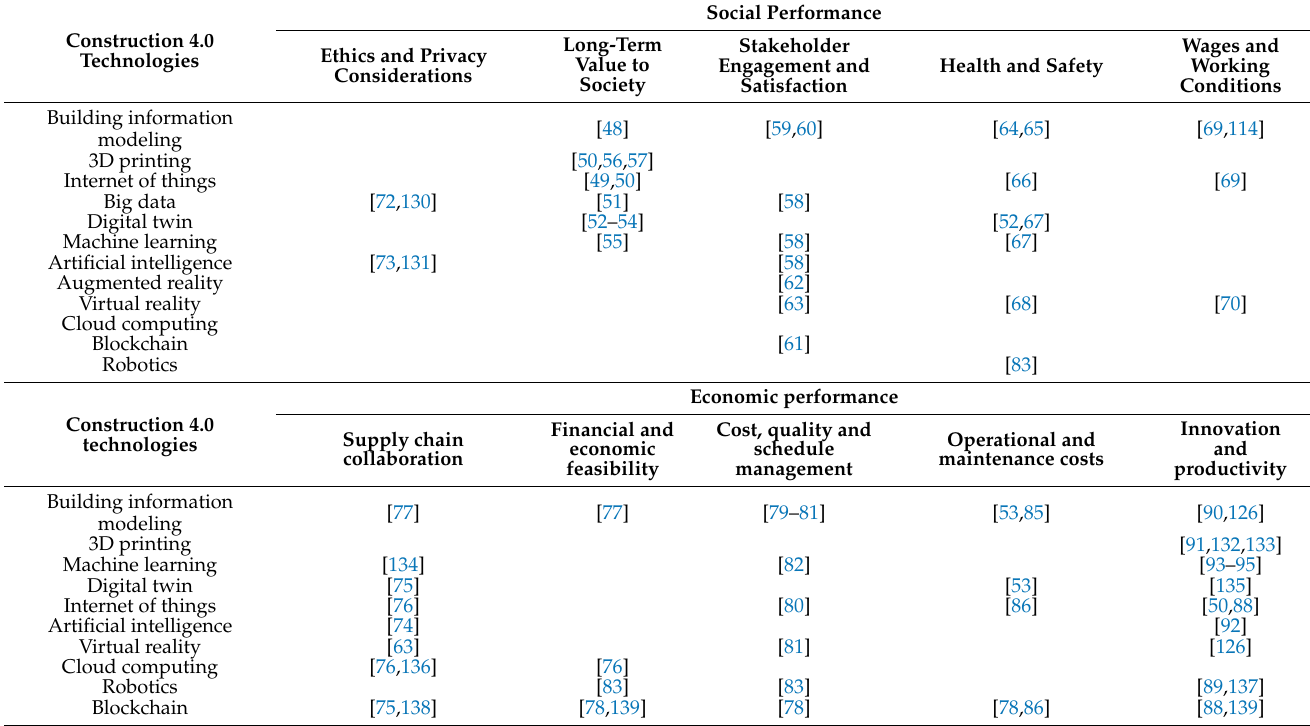
Table 11. Summary of literature on C4.0 technologies and SD